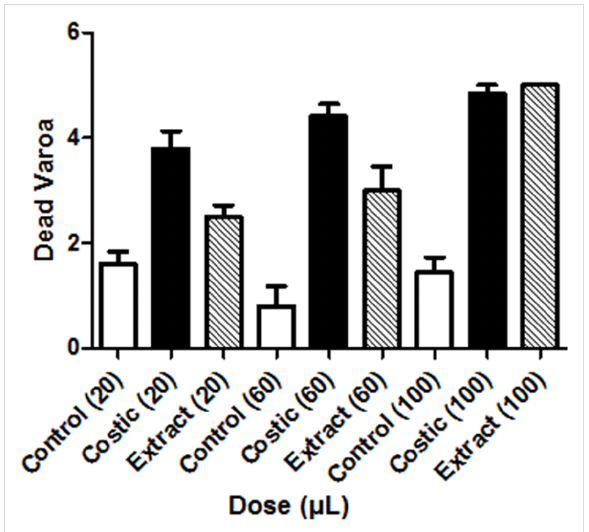
Figure 1: Mortality of V. destructor (number of mites) after 12 h treat- ment with 20, 60, or 100 μ L dose of acaricide. The number in paren- thesis indicates the microliters of solution used in each experiment. “Costic” indicates the use of costic acid solution and “extract” refers to the solution of the total methanol extract. Each vial, including controls, contained five mites. In control experiments, an equal number of microliters of acetone were added to the system. In all cases the sol- vent was allowed to evaporate before covering the